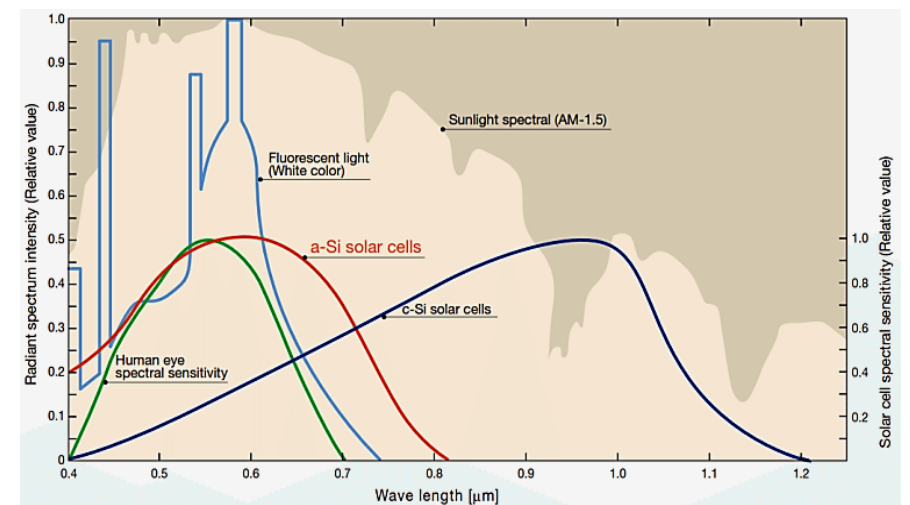
Fig.1: The spectral response of different types of solar cells, adopted from ref. [9].